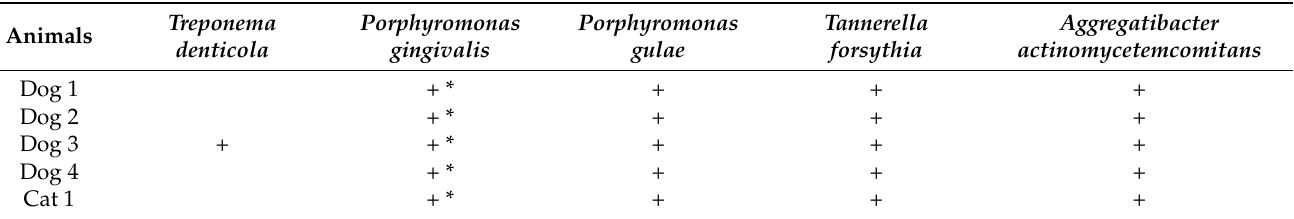
Table 5. The presence of periodontal pathogens in dental plaque of companion